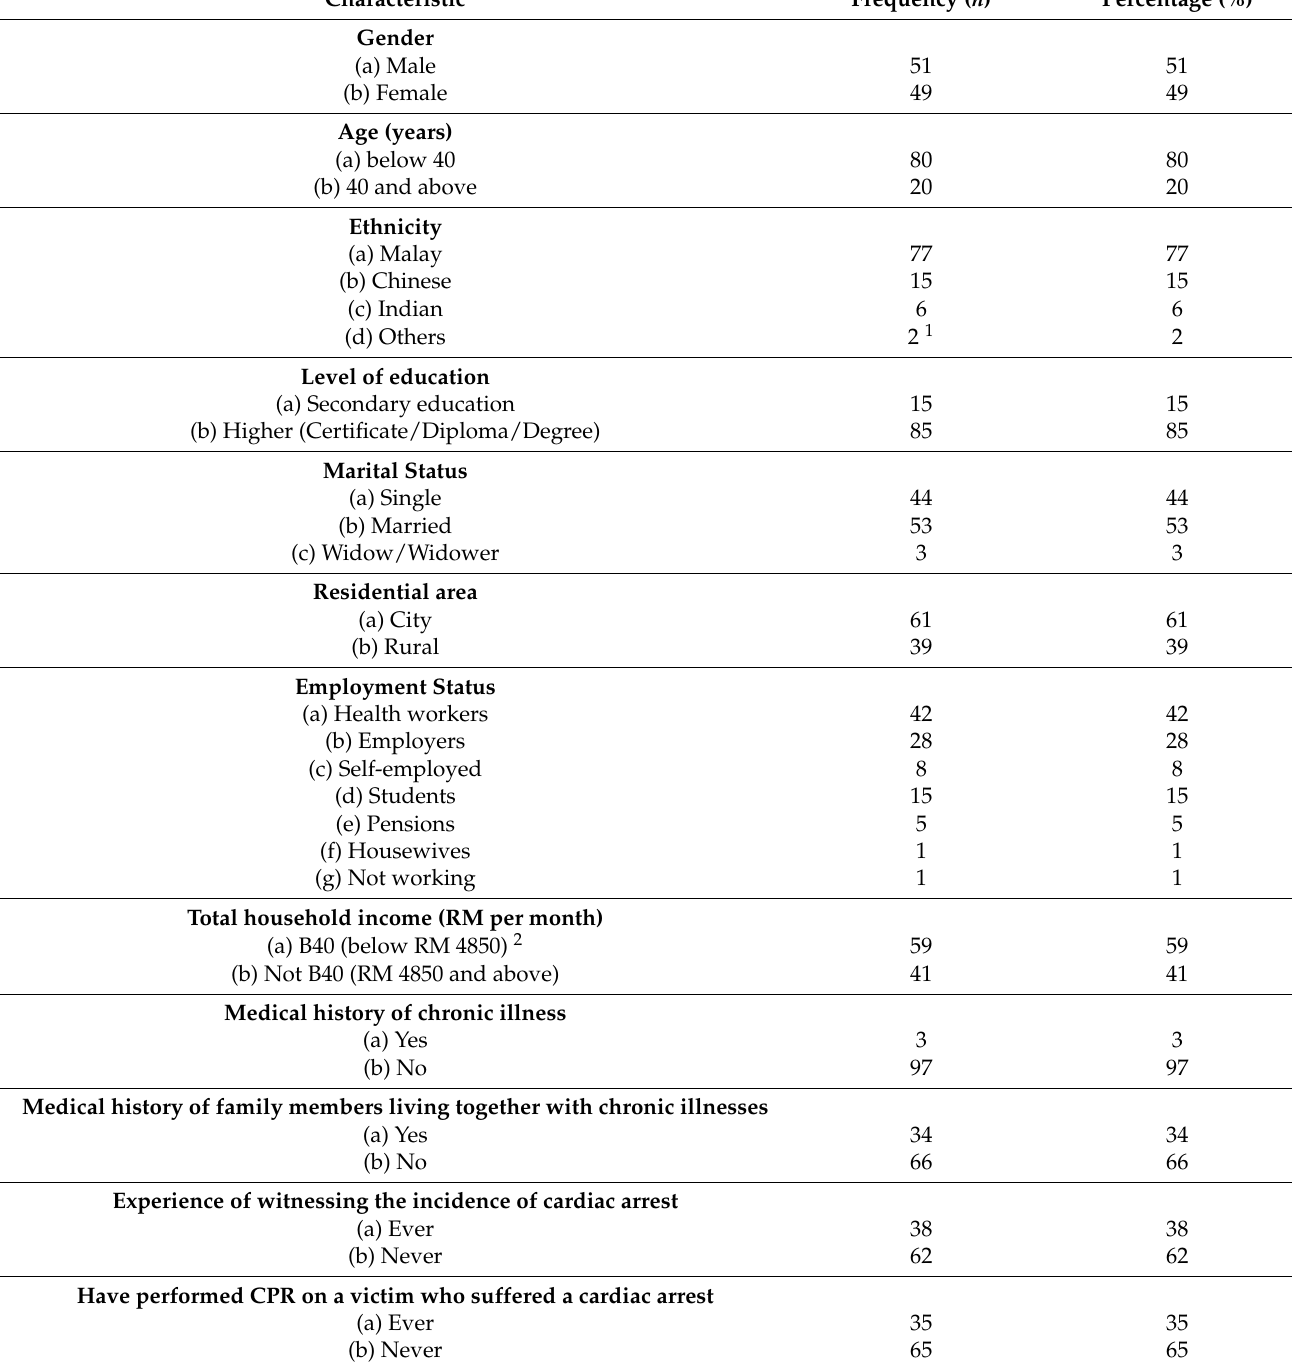
Table 1. Socio-demographics characteristics of the participants ( n =